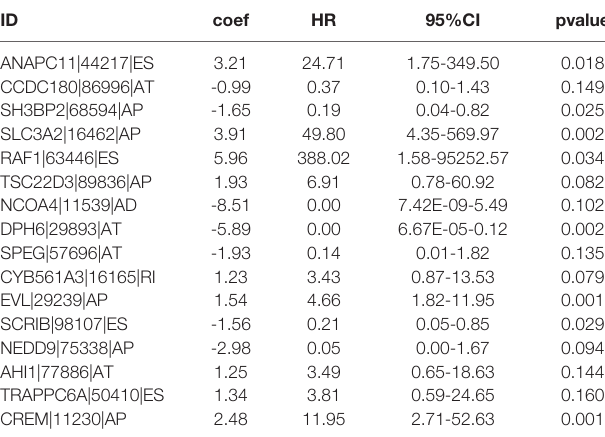
TABLE 1 | The information of 16 OS-related DEAS events by multivariate Cox analysis. ID coef HR